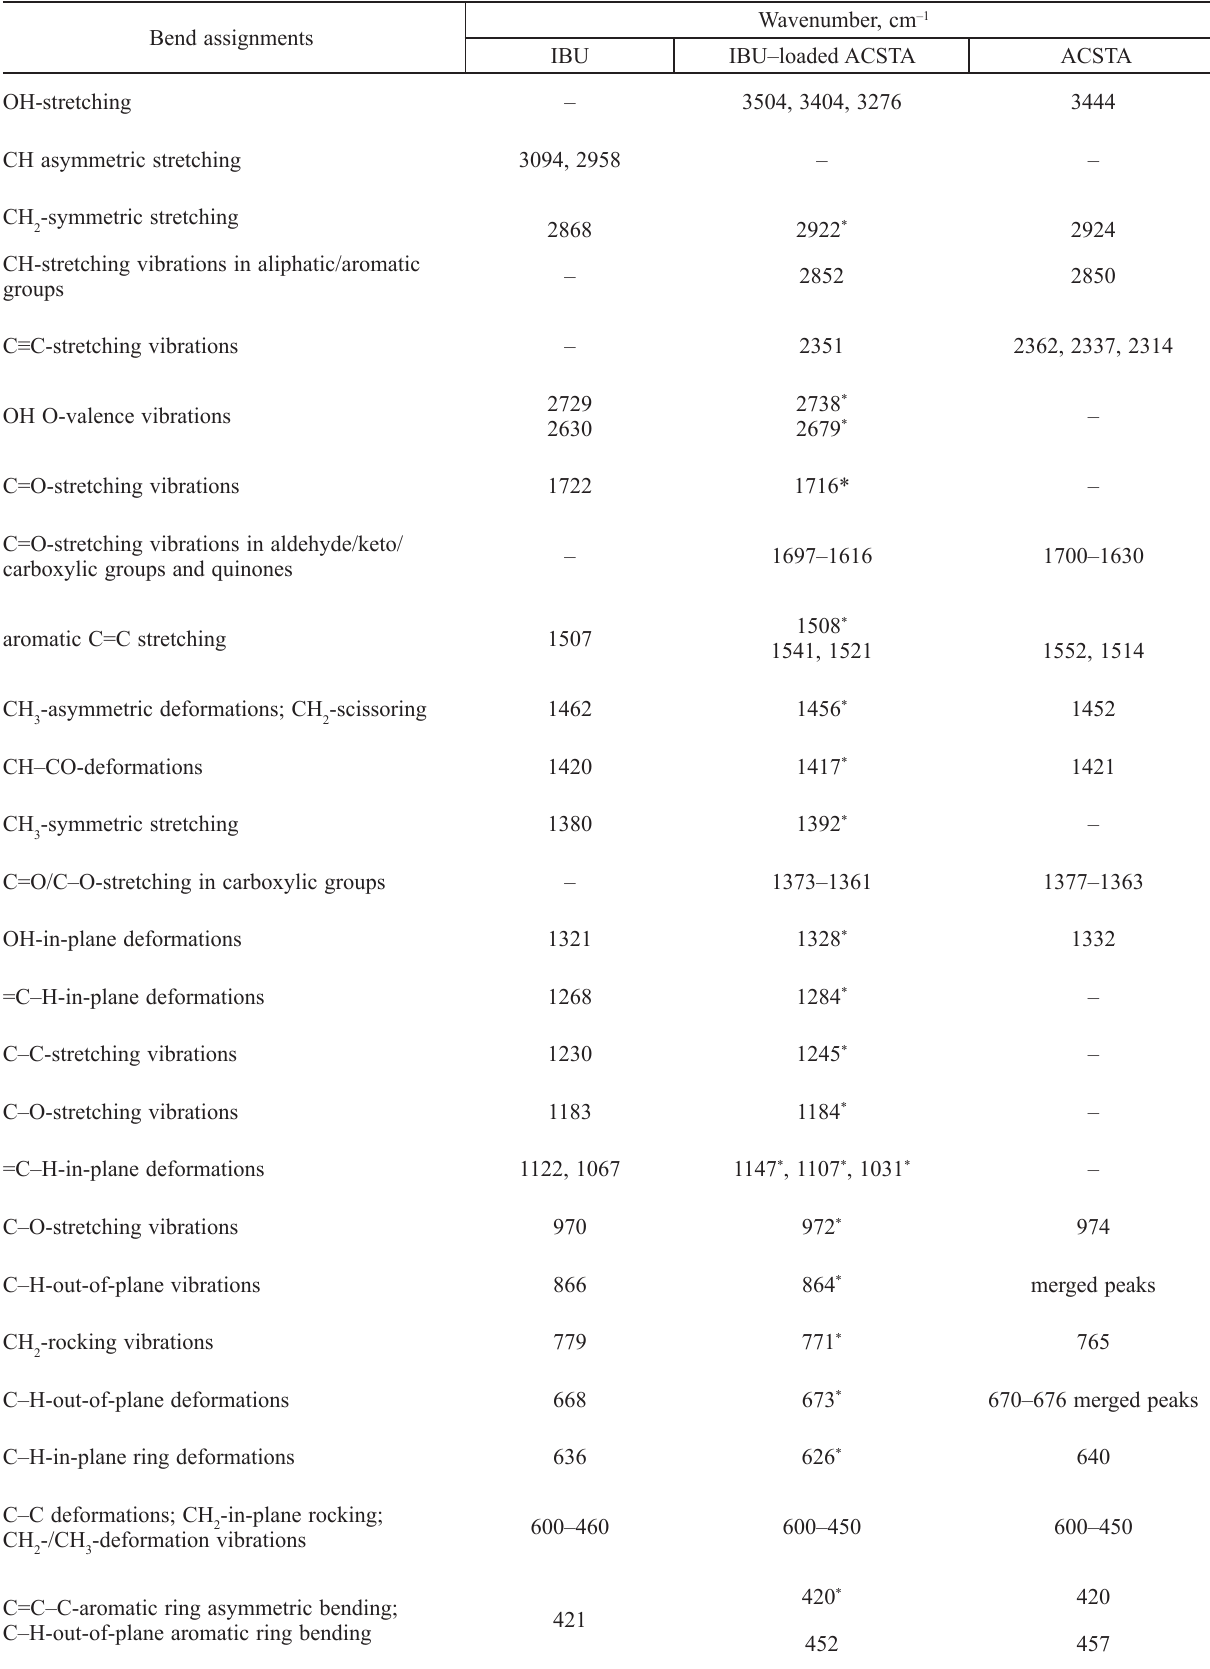
Table 3 – Characteristic FTIR vibrations and bends of IBU, ACSTA and IBU-loaded ACSTA 23–25 Bend